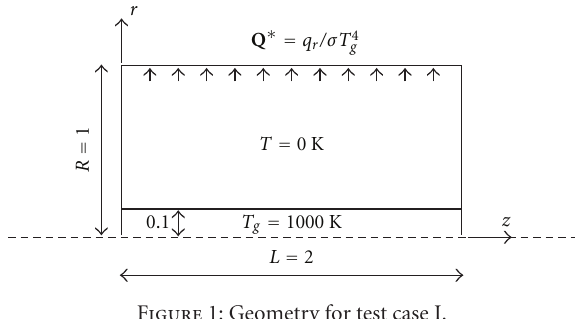
Figure 1: Geometry for test case